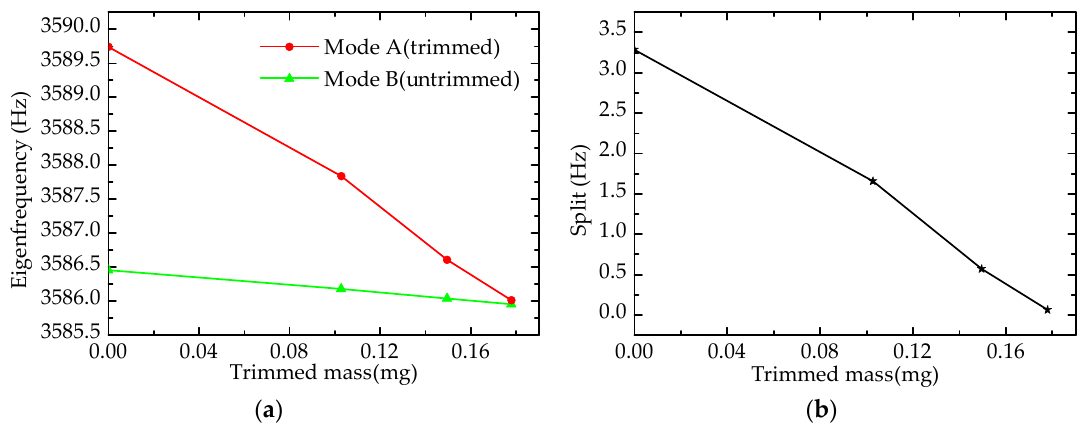
Figure 15. Experimental results of forming grooves on the top edge of the wall: ( a ) Eigenfrequency; ( b ) Frequency split.